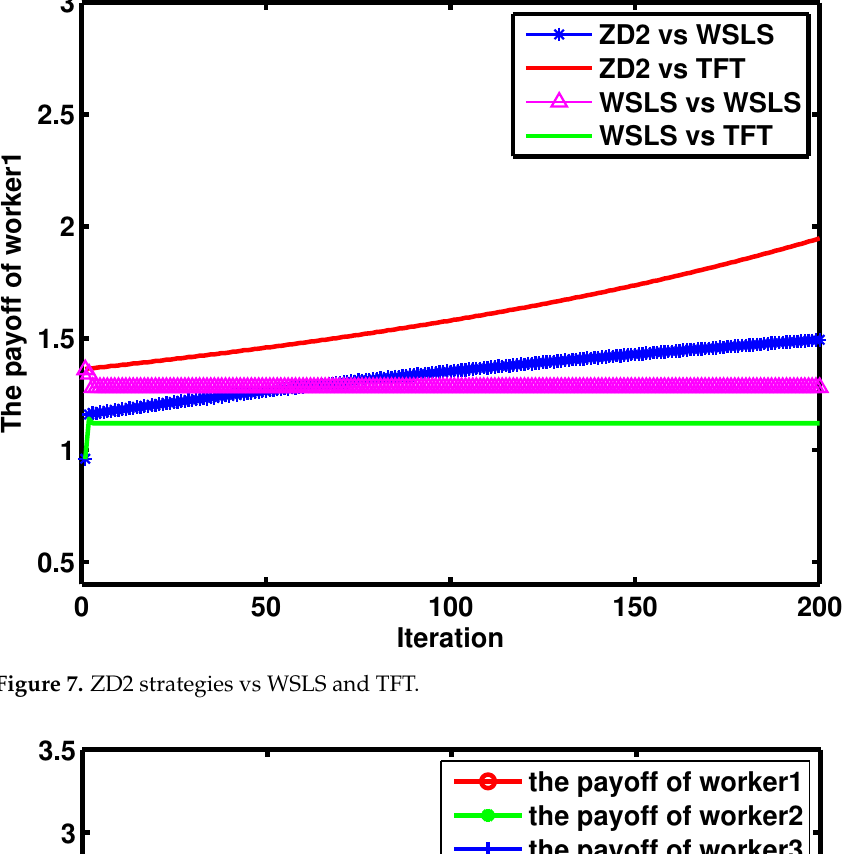
Figure 7. ZD2 strategies vs WSLS and TFT.